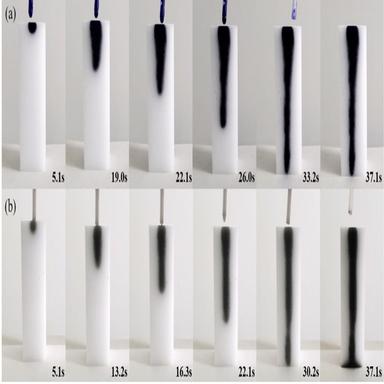
Comparative test of permeability of methyl blue stained deionized water on (a) absorbent sponge and (b) superhydrophobic coatings treated absorbent sponge.